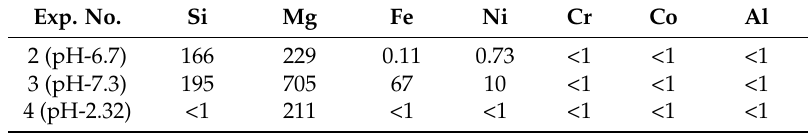
Table 3. Chemical analysis of Si, Mg, Fe, Ni, Cr, and Al in solution (mg/L) after carbonation. Exp. No. Si Mg